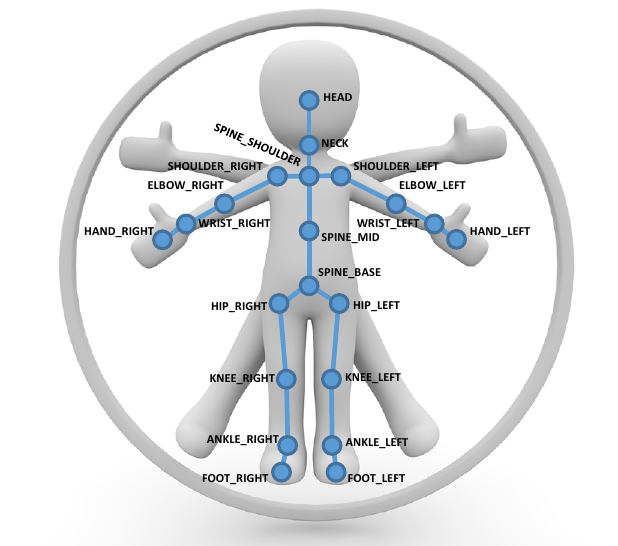
Figure 4. An illustration of the Kinect SDK pose representation using 21 joints with edges corresponding to the bones in between to represent human